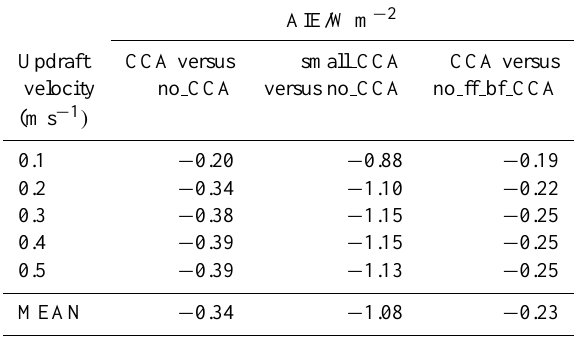
Table 5. Calculated global mean top-of-atmosphere aerosol indirect effect (AIE) due to carbonaceous combustion aerosol for a range of cloud updraft velocities. Model experiments as described in Table 3. The perturbed and unperturbed simulations are detailed in the table.